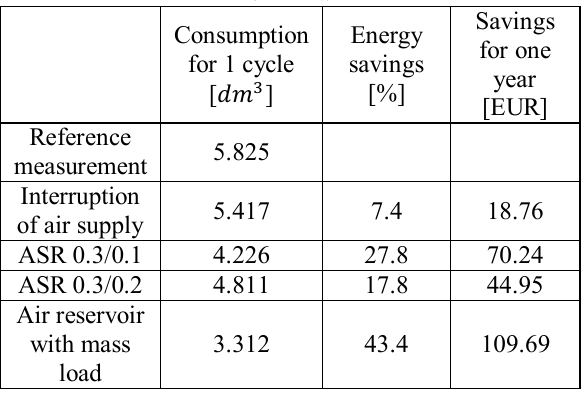
Tab. 6. Energy savings for measured tasks, working pressure 0.4